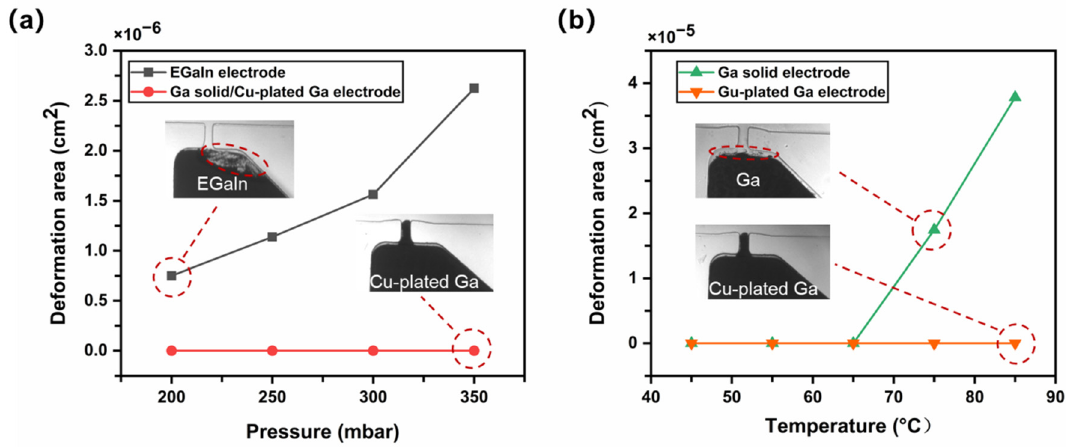
Figure 5. Pressure and temperature resistance tests of different microelectrodes: ( a ) Pressure resistance comparison between EGaIn and Ga solid/Cu-plated Ga electrodes at 25 °C. ( b ) Temperature resistance comparison between Ga solid electrode and Cu-plated Ga electrode at 300 mbar.